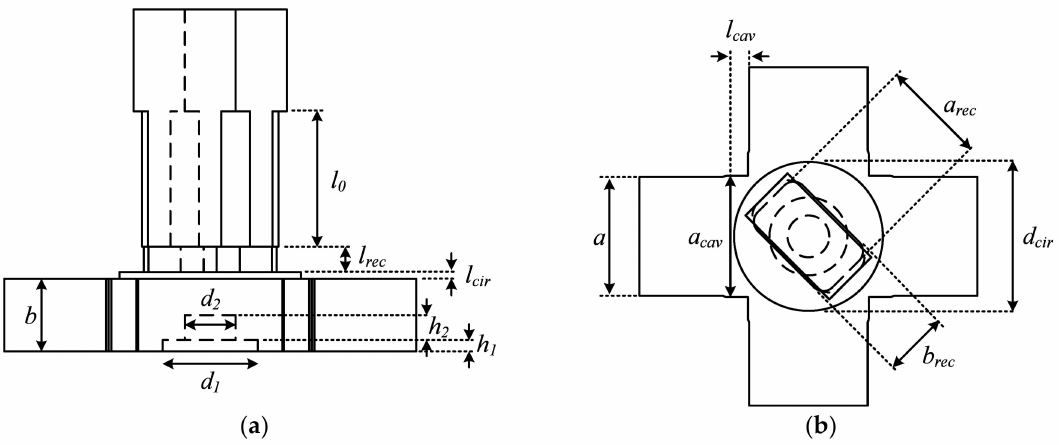
Figure 2. Junction design parameters definition in: ( a ) side view and; ( b ) top view.